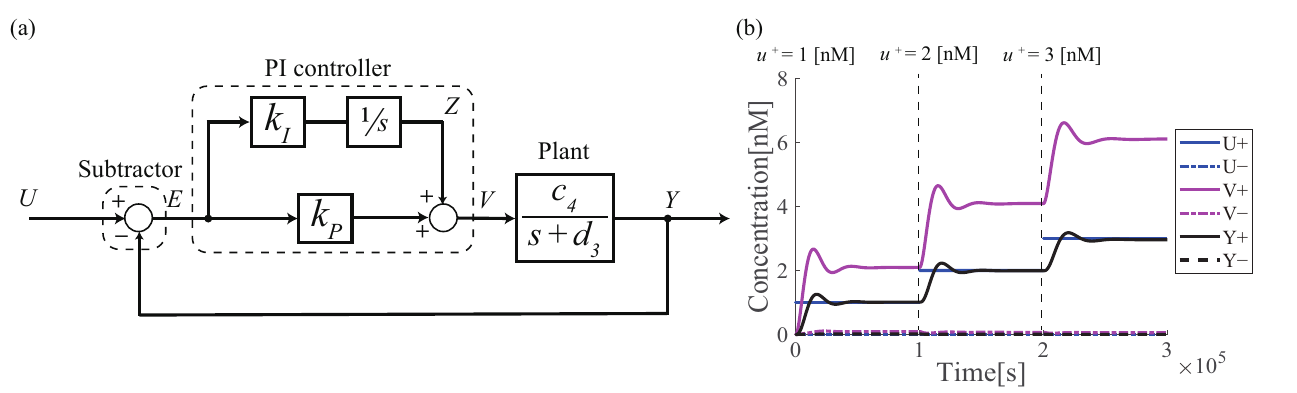
Figure 1. ( a ) Block diagram of the PI controller. This controller consists of 162 DNA strands. ( b ) simulation results of the PI controller. Each reaction rate is c 1 = c 2 = c 3 = k I = k P = 0.0008, c 4 = 0.0004, and k = 1.0 × 10 − 3 nM − 1 s − 1 . The concentrations of fuel DNA strands used in the PI controller were obtained from the program (Examples—PI Controller—2Domain) on Visual DSD [26] and are shown in Figure S1. The input U + is first given 1 nM at 0 s, then the input is increased to 2 nM at 1.0 × 10 5 s, and then to 3 nM at 2.0 × 10 5